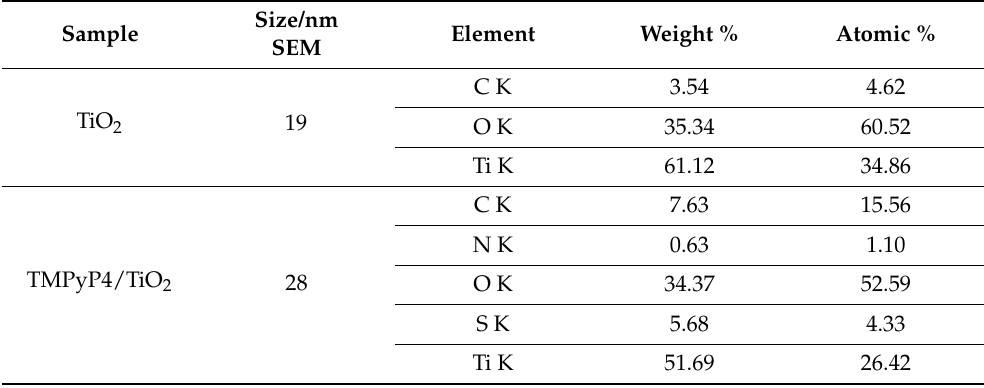
Table 1. Dimension of the particles and EDS analysis of the TiO 2 and TMPyP4/TiO 2 samples.